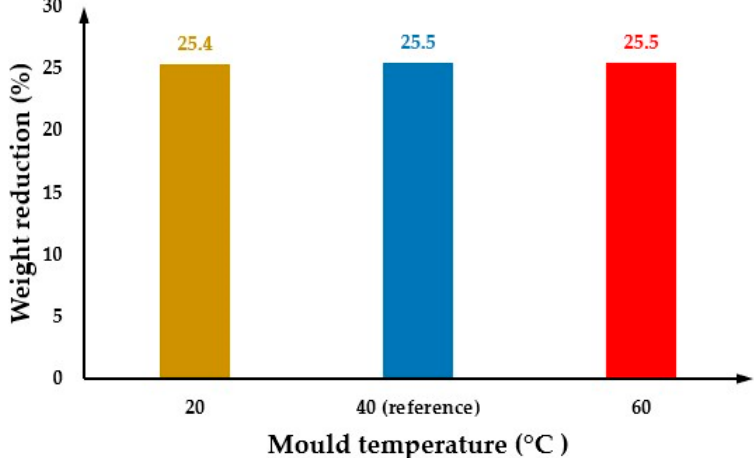
Figure 8. The weight reduction as a function of mould temperature.